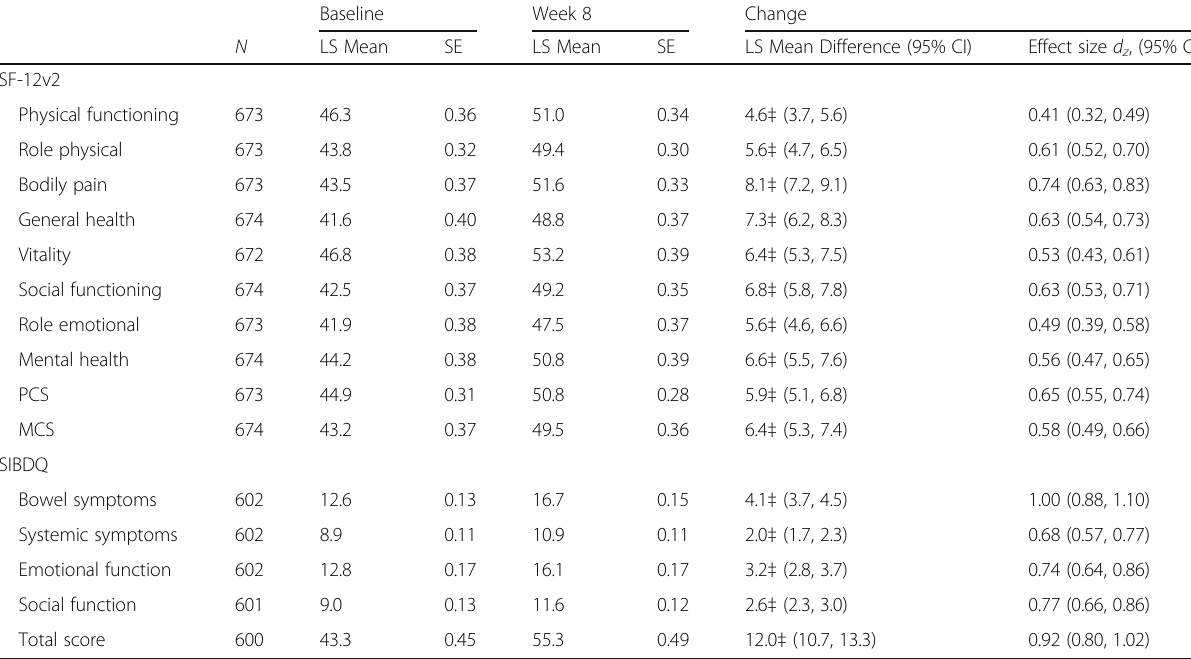
Table 2 SF-12v2 and SIBDQ scores for the acute phase sample at acute phase visits